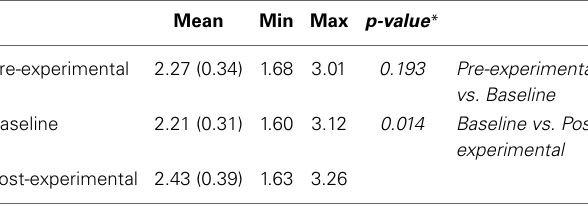
Table 5 | Mean (SD) and range of Plaque index